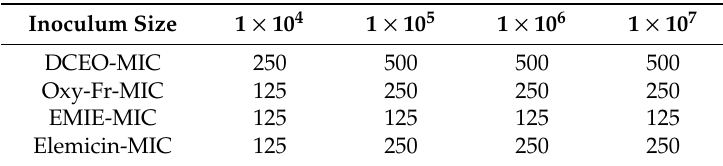
Table 2. E ff ect of the inoculum size on